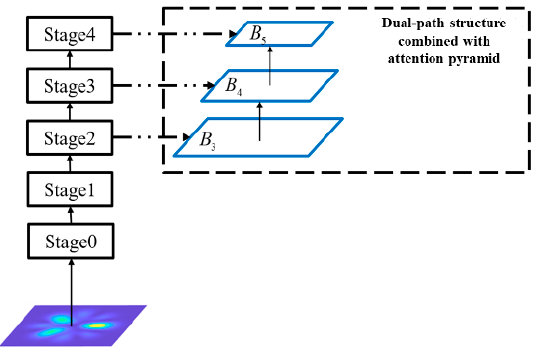
Figure 4. Connection between ResNet18 and the refinement network.